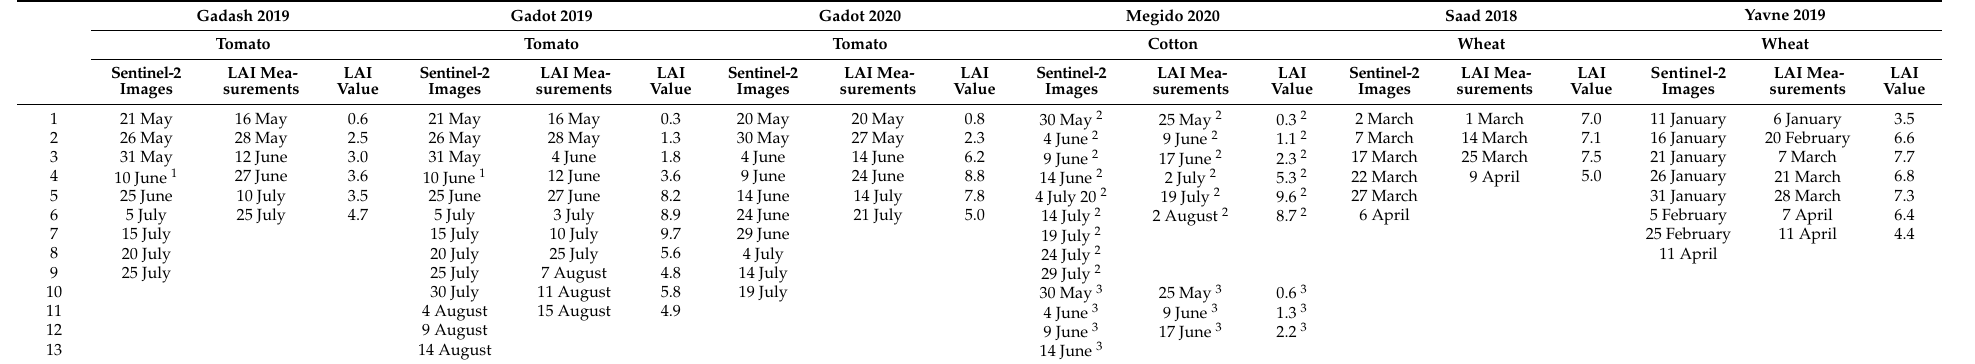
Table A1. Sentinel-2 images inventory and LAI measurements data used in the